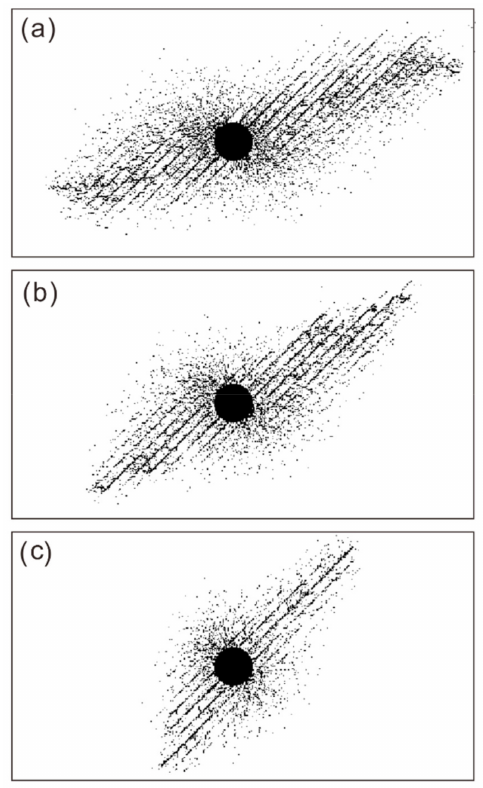
Figure 8. Fracture distribution for bedding planes oriented at 45 ◦ . The in-situ stress ratios were 1.5, 1.25, and 1.0, respectively. The injection rate was consistent with the base model. ( a ) In-situ stress ratio